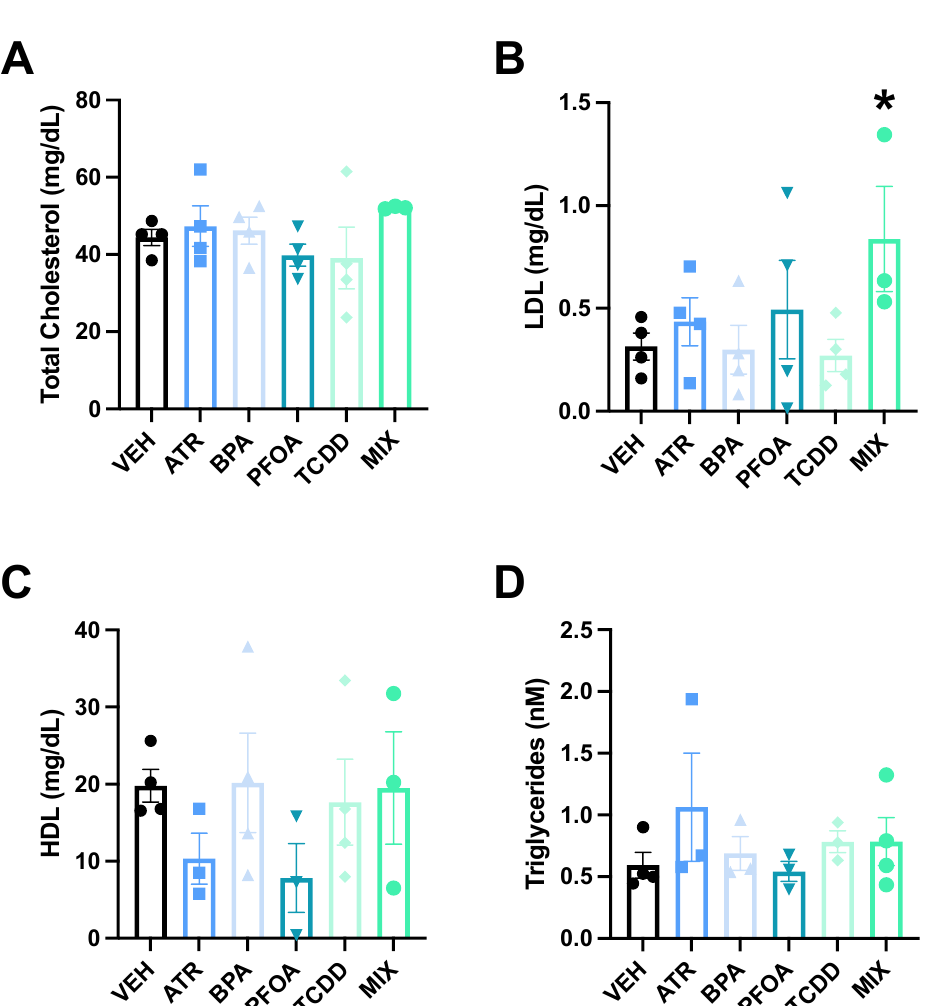
Figure 2. Pregnant Dams Serum Lipids. Following a glucose tolerance test, a cholesterol panel was performed on the serum. LDL ( B ) was significantly elevated only in the MIX dams. Total cholesterol ( A ), HDL ( C ), and triglycerides ( D ) did not differ in any treatment group. Data are presented as mean ± standard error ( n = 3 – 4/group). Asterisk indicates p ≤ 0.05.